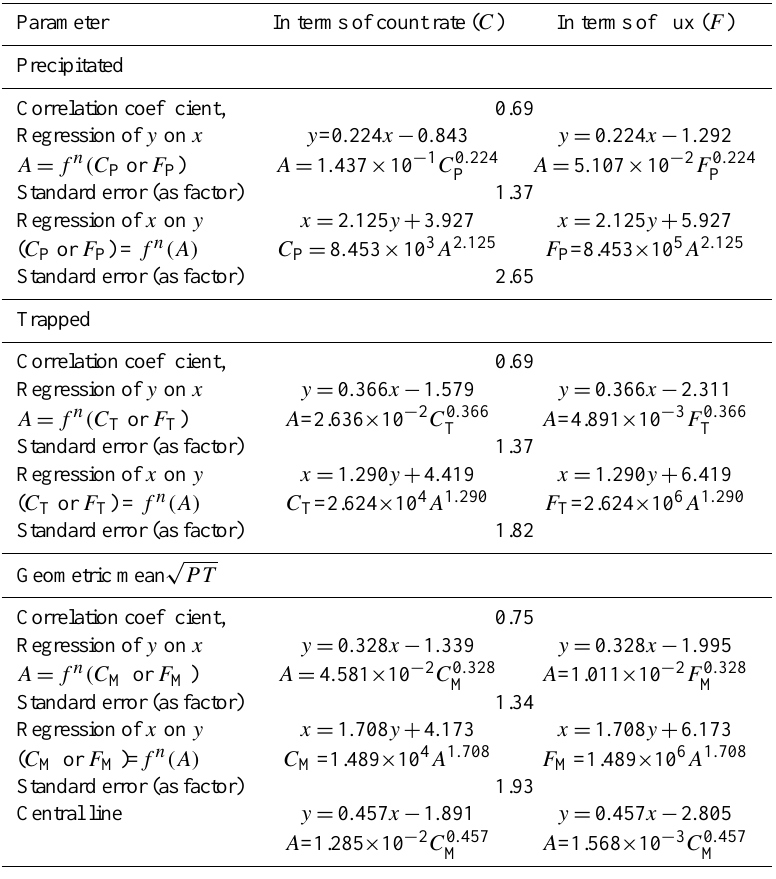
Table 3. Summary of the statistics from Fig. 6, showing the regression analysis for the whole day between log(absorption) and log(30keV count rate) both for the trapped and precipitated populations, and for their geometric mean. In the table, A =absorption(dB), y =log[ A ] and x =log(count rate) or log(flux).